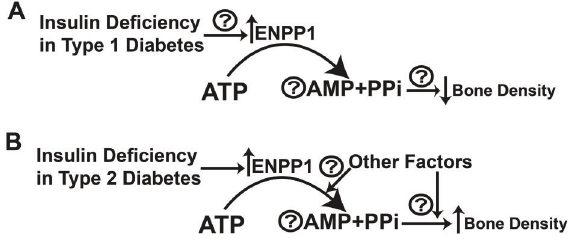
Figure 5. Hypothetical potential roles and remaining questions of ENPP1 in bone health changes in patients with type 1 or type 2 diabetes. A , In type 1 diabetes, insulin de fi ciency may lead to an increase of ENPP1 expression. This may cause the increase